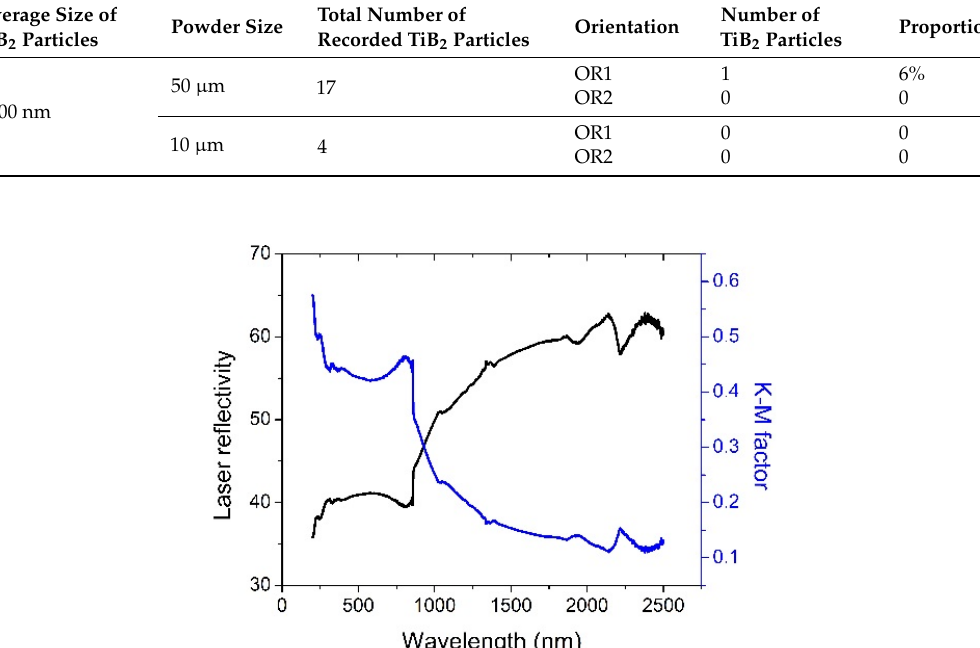
Table 2. Orientation relationship summary of all the recorded TiB 2 particles at the grain boundaries by EBSD.